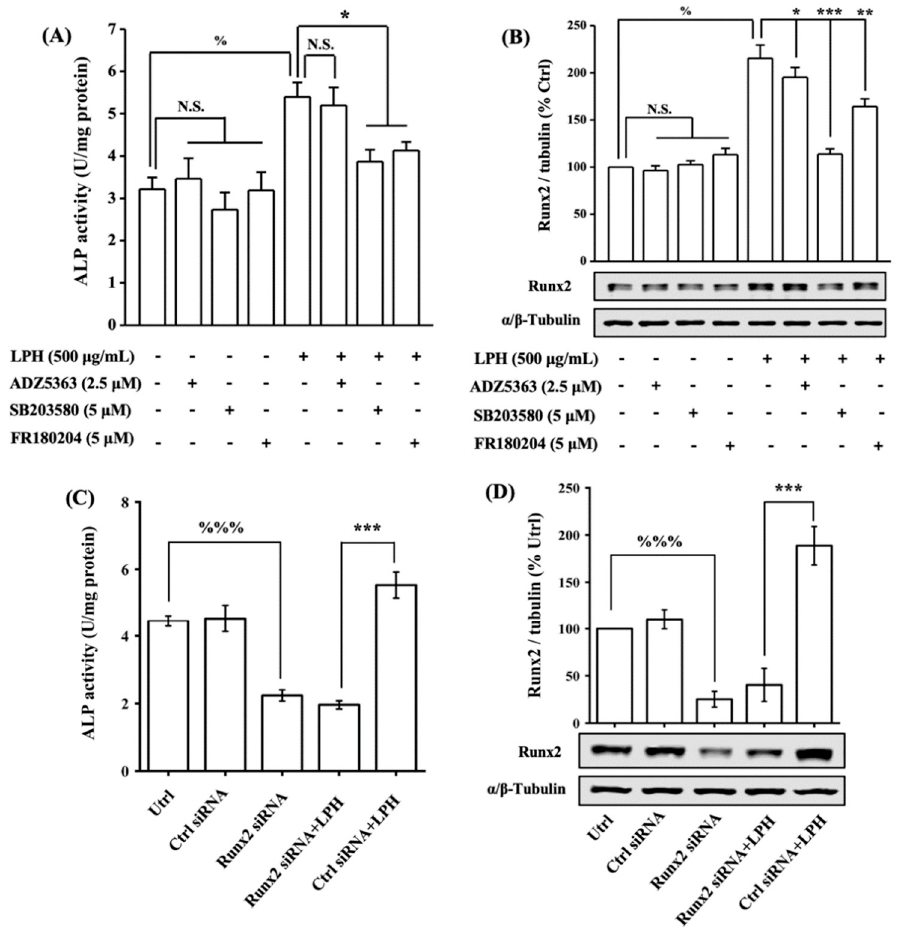
Figure 7. LPH stimulated osteoblast differentiation through p38/Runx2 pathway. ( A , B ) Effect of MAPK and Akt signaling specific inhibitors on LPH-induced ALP activity and Runx2 expression in MC3T3-E1 osteoblasts. Cells were seeded on six-well plates until confluency and were serum-starved in α -MEM for 12 h. Then cells were individually pretreated with or without 5 µ M SB203580 (p38 MAPK inhibitor), 5 µ M FR180204 (ERK1/2 MAPK inhibitor), and 2.5 µ M ADZ5363 (Akt inhibitor) for 2 h, prior to coincubation with 500 µ g/mL of LPH for 24 h to detect ( A ) ALP activity and ( B ) Runx2 expression. ( C , D ) Effect of Runx2 knockdown on LPH-induced ALP activity and Runx2 expression in MC3T3-E1 osteoblasts. Cells were seeded on six-well plates until 50% confluency and were transfected with Runx2 siRNA or control (Ctrl) siRNA for 48 h, prior to coincubation with 500 µ g/mL of LPH for 24 h to detect ( C ) ALP activity and ( D ) Runx2 expression. The expression of α / β -tubulin was used as the loading control to Runx2. Data are represented as the mean ± SEM, n = 3. % and %%% indicate p < 0.05 and p < 0.001, as compared to the control group. *, ** and *** indicate p < 0.05, p < 0.01 and p < 0.001, as compared to the LPH treated group. N.S. indicated p > 0.05.